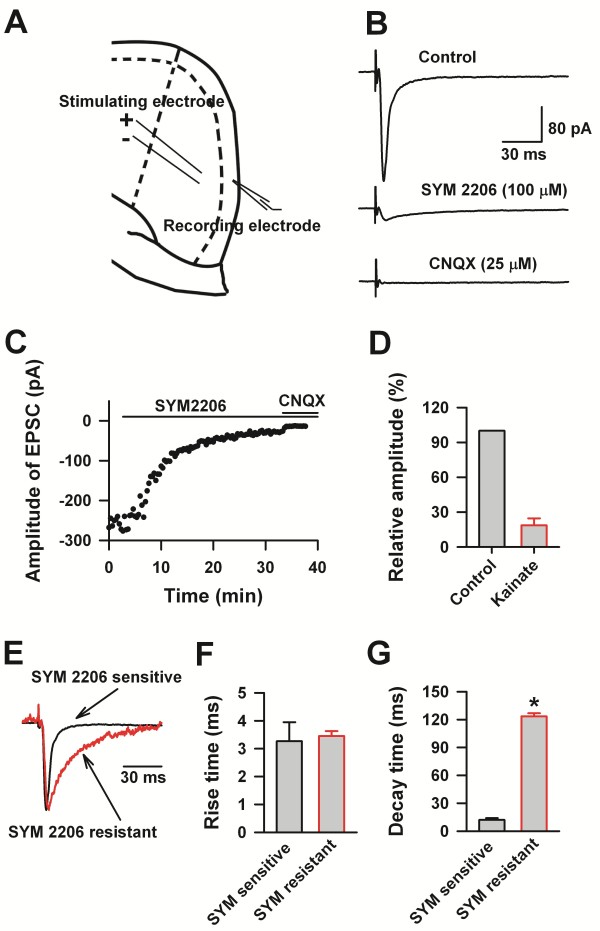
AMPA and kainate receptor-mediated excitatory postsynaptic currents in LI neurons of the adult ACC. A), Diagram showing the placement of stimulating and recording electrode in the ACC. B), The control represented evoked EPSCs recorded under the blocking of GABAA and NMDA receptors activities with bath application of PTX (100 μM) and D-2-amino-5-phosphono-pentanoic acid (D-AP5, 50 μM). After application of SYM 2206 (100 μM), the residual currents were totally blocked by CNQX (25 μM). Each trace represented an average of 5–10 consecutive recording. C), Example showing the time course of SYM 2206 and CNQX effects on the neuron showed in B. D), The statistic data showing the percentage of SYM 2206 resistant-CNQX sensitive currents. E), Scaled traces showed the different kinetics of SYM 2206 sensitive and resistant currents. F), Pool data showing the rise time of SYM 2206 sensitive and resistant currents were similar. G), Summarized data showing the decay time of SYM 2206 sensitive and resistant currents were different. “*” indicate P < 0.05.